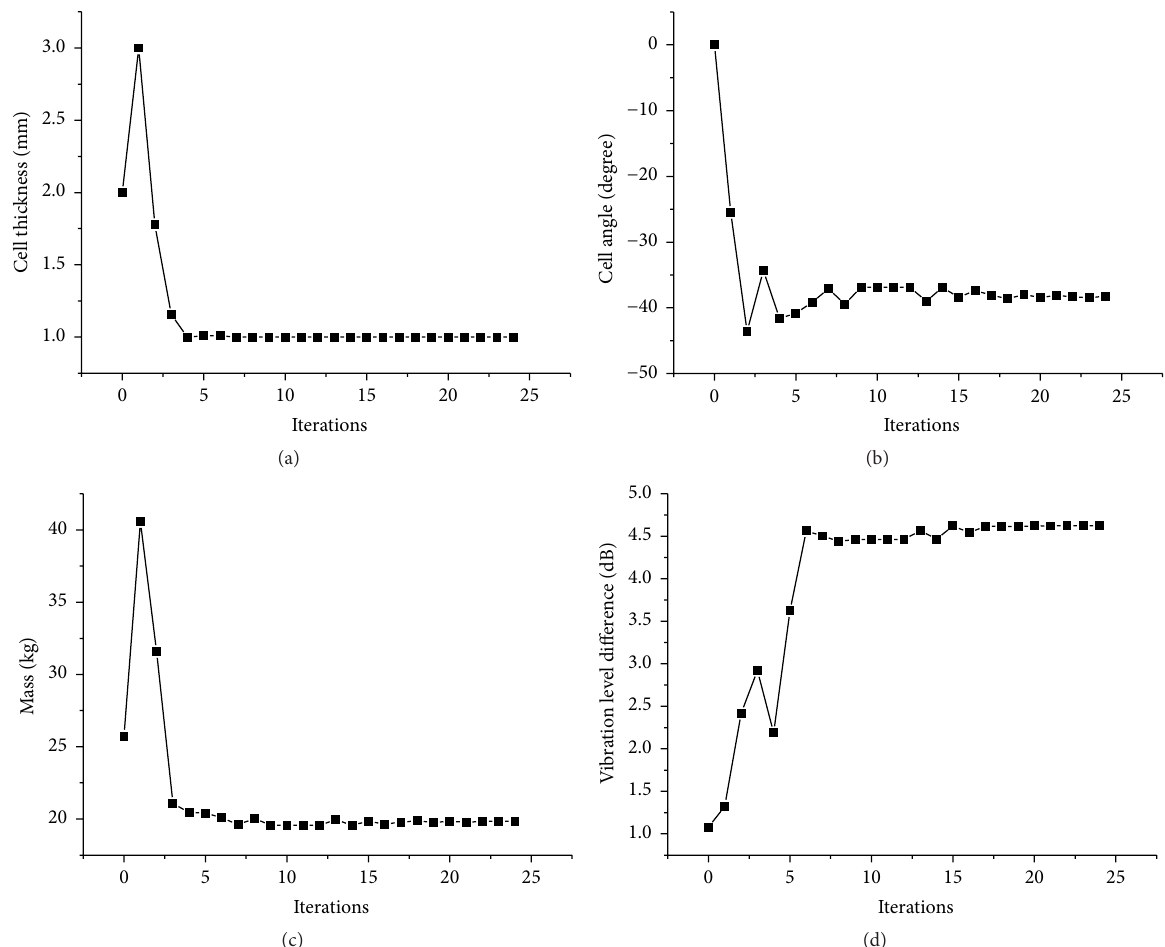
Figure 11: Iteration curve of (a) cell thickness, (b) cell angle, (c) mass of honeycombs, and (d) vibration level difference.